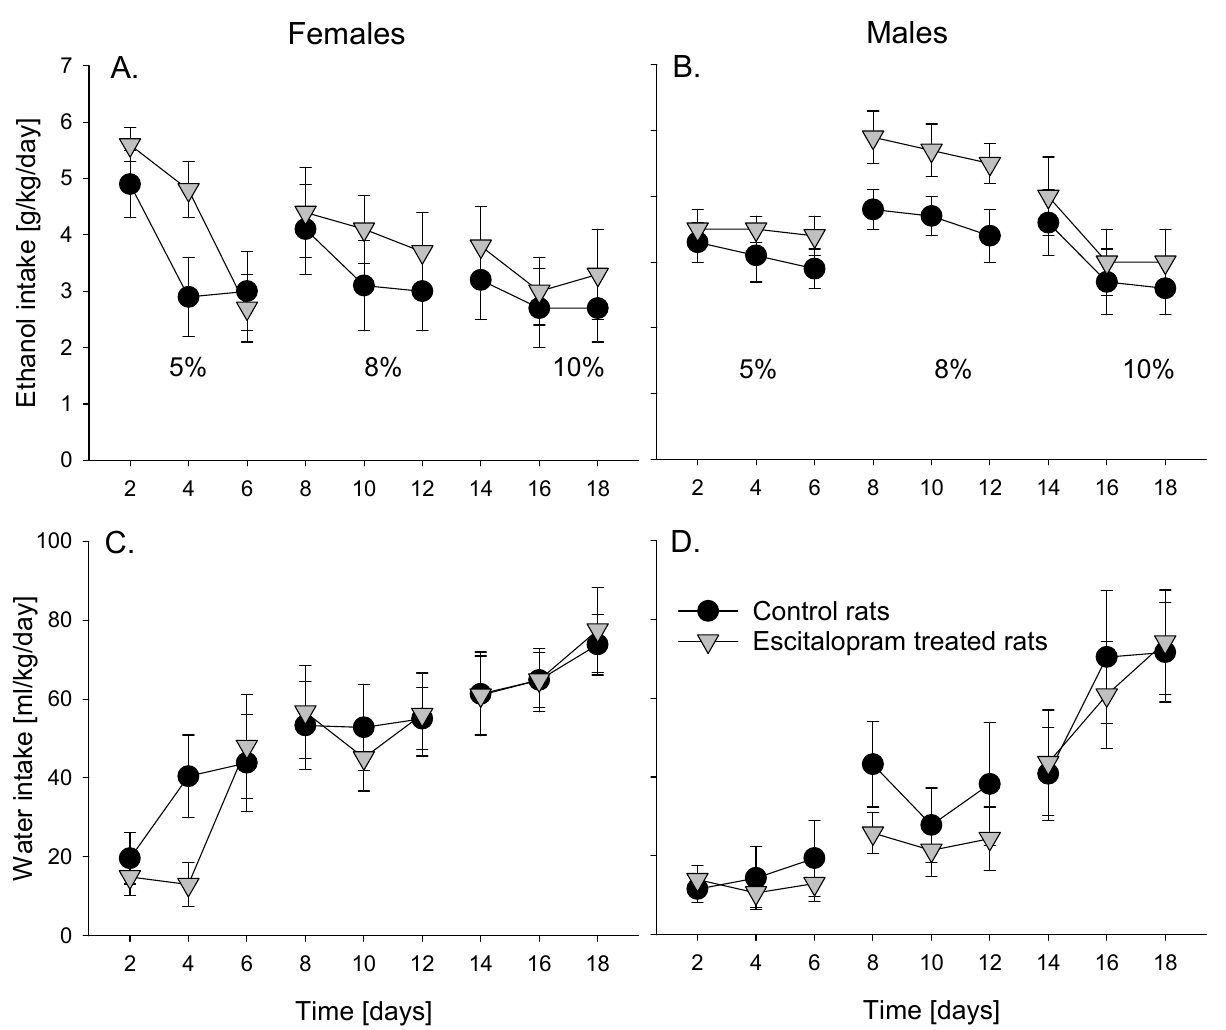
Figure 2. Total daily ethanol (in g of pure ethanol per kg of body weight per 24 h, g/kg/day, ( A , B )) and water (in ml/kg/day, ( C , D )) intake in control and escitalopram-treated female ( A , C ) and male ( B , D ) rats ( n = 12 per group). All rats were given intermittent (every second day) access to tap water and alcohol solution for a total of 18 days. During this procedure, rats had access to 5% ethanol solution for 3 days, 8% ethanol solution for the next 3 days and 10% ethanol solution for 3 more days. Data are presented as means ± S.E.M.